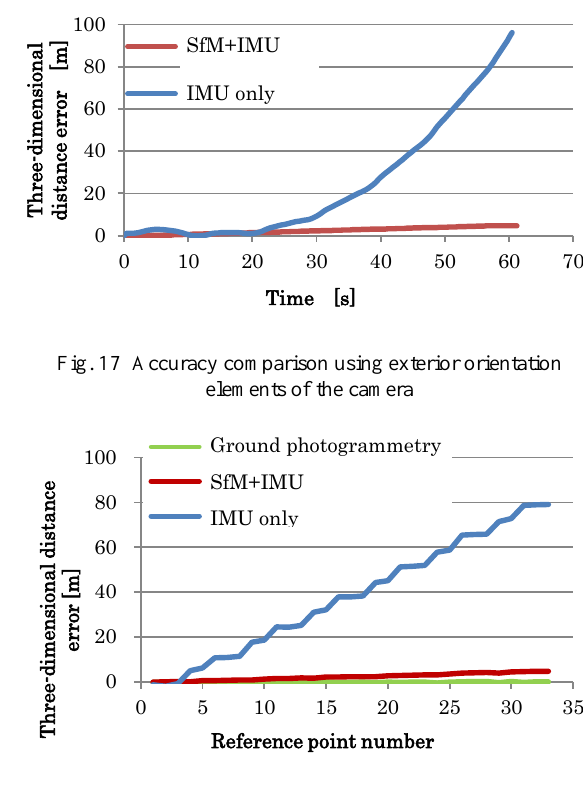
Fig. 18 Accuracy comparison using validated